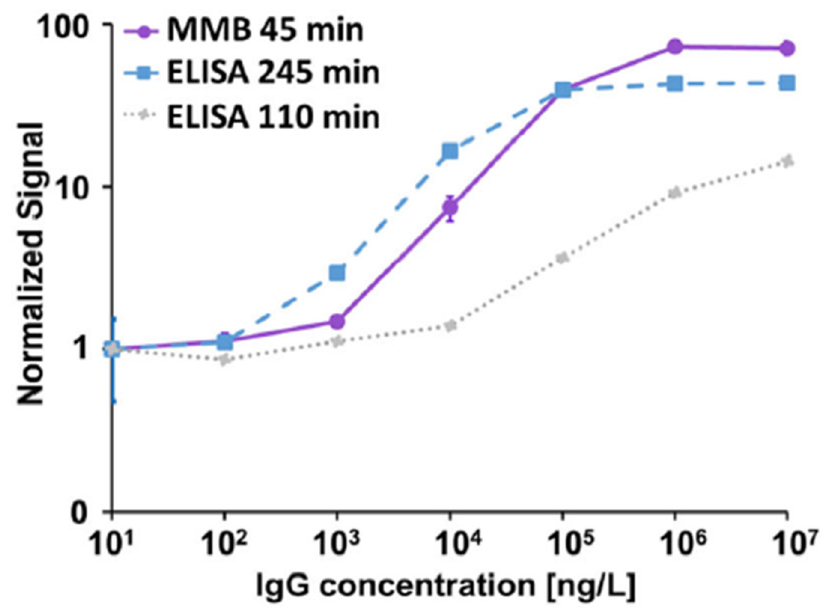
Figure 3. Dose response comparison between the 45-min MMB-based assay and the 110- and 245-min ELISA tests. The calculated LoD of the MMB test is 129 ng/L. The calculated LoDs of the ELISA tests are 6267 and 817 ng/L, respectively. Reprinted from [25] with the permission of MDPI 2022.